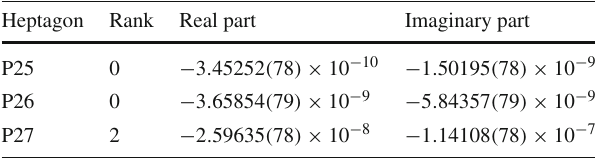
Table 6 Scalar and rank-two tensor heptagons